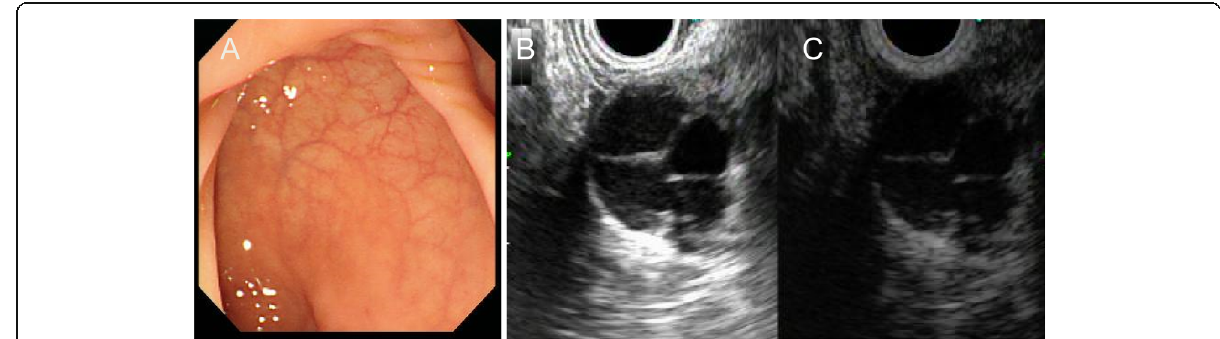
Fig. 1 Colonoscopy and endoscopic ultrasound. a No rectal submucosal tumor is seen on colonoscopy. b The endoscopic ultrasonography (EUS) shows a hypo- and anechoic multilocular mass measuring 20 mm in diameter with clear boundaries. c Only the cyst wall is enhanced on contrast-enhanced ultrasonography (CE-US)